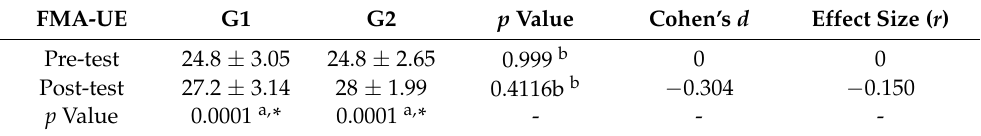
Table 2. Fugl-Meyer Assessment of the upper extremity (FMA-UE) of the affected UE in both groups.